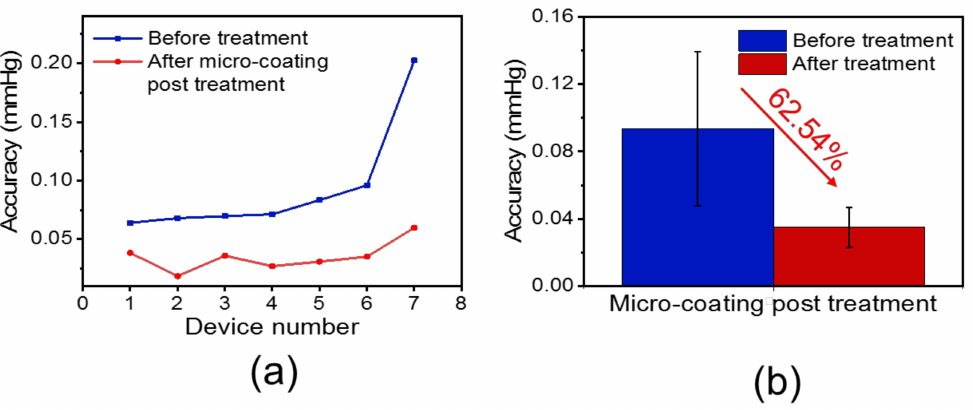
Figure5. ( a )Accuracyofthedevicesbeforeandafterapplyingthemicro-coatingcladdingpost-treatment. ( b ) After employing the proposed micro-coating post-treatment method, the accuracy of the whole devices decreased by approximately